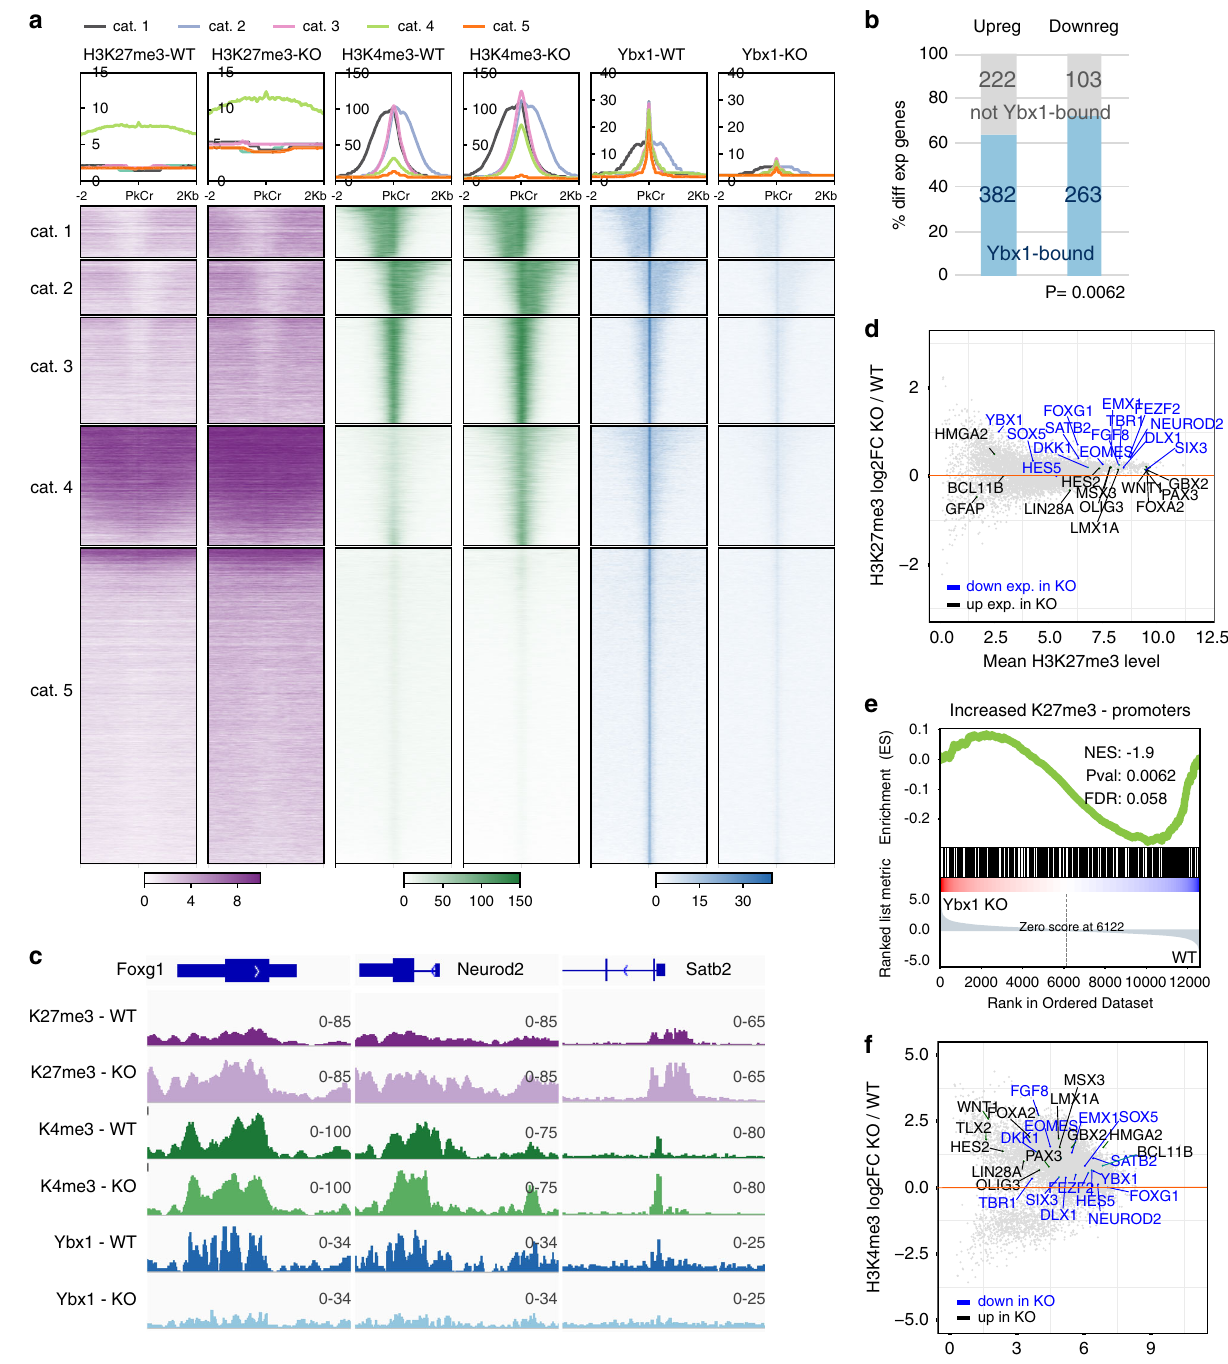
Fig. 4 Ybx1 suppresses H3K27me3 levels. a Heat maps indicate the binding intensity of H3K27me3, H3K4me3, and Ybx1, with low (white) or high (dark color) intensity, within 2 kb of all Ybx1 CUT&RUN-seq peaks. Average binding pro fi les from fi ve different categories (cat.) are presented. In all fi ve categories, H3K27me3 levels increased in Ybx1 -KO NPCs. Cat. 1, H3K4me3 peaks to the left of Ybx1 peaks; 2, H3K4me3 peaks to the right of Ybx1 peaks; 3, H3K4me3 peaks at Ybx1-bound peak center; 4, high H3K4me3 increase in Ybx1 -KO; 5, no H3K4me3. b Proportion of differentially expressed genes in Ybx1 - KO vs. WT NPCs bound by Ybx1 protein in control NPCs. P values were calculated by two-tailed Fisher ’ s exact test. c H3K27me3 and H3K4me3 ChIP-seq and Ybx1 CUT&RUN-seq tracks at Foxg1 , Neurod2 , and Satb2 gene loci in Ybx1 -KO and sibling control NPCs. d MA plot of LOG2(H3K27me3 fold-changes of Ybx1 -KO/WT NPCs) versus mean H3K27me3 levels at individual genes. Blue indicates downregulated genes and black indicates upregulated genes in Ybx1 -KO NPCs. e GSEA of genes containing signi fi cantly increased H3K27me3 levels at promoters with differentially expressed genes in Ybx1 -KO